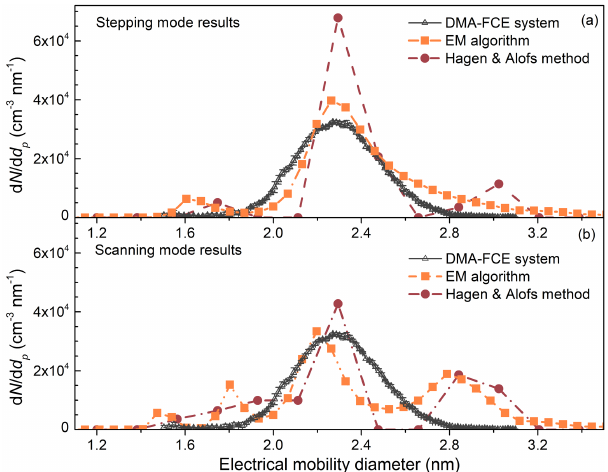
Figure 12. The recovered particle size distributions using the par- ticle number concentration recorded in (a) the stepping mode and (b) the scanning